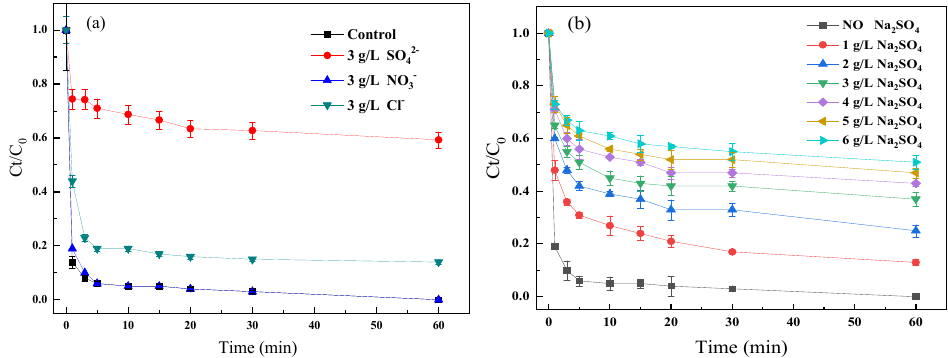
Figure 1. Effect of anions and sulfate on the degradation of RBR X-3B by ferrous/PS system: ( a ) anions; ( b ) sulfate. [X-3B] 0 = 50 mg/L, [PS] 0 = 40 mg/L, Fe 2+ /PS molar ratio = 0.3, and pH = 7.